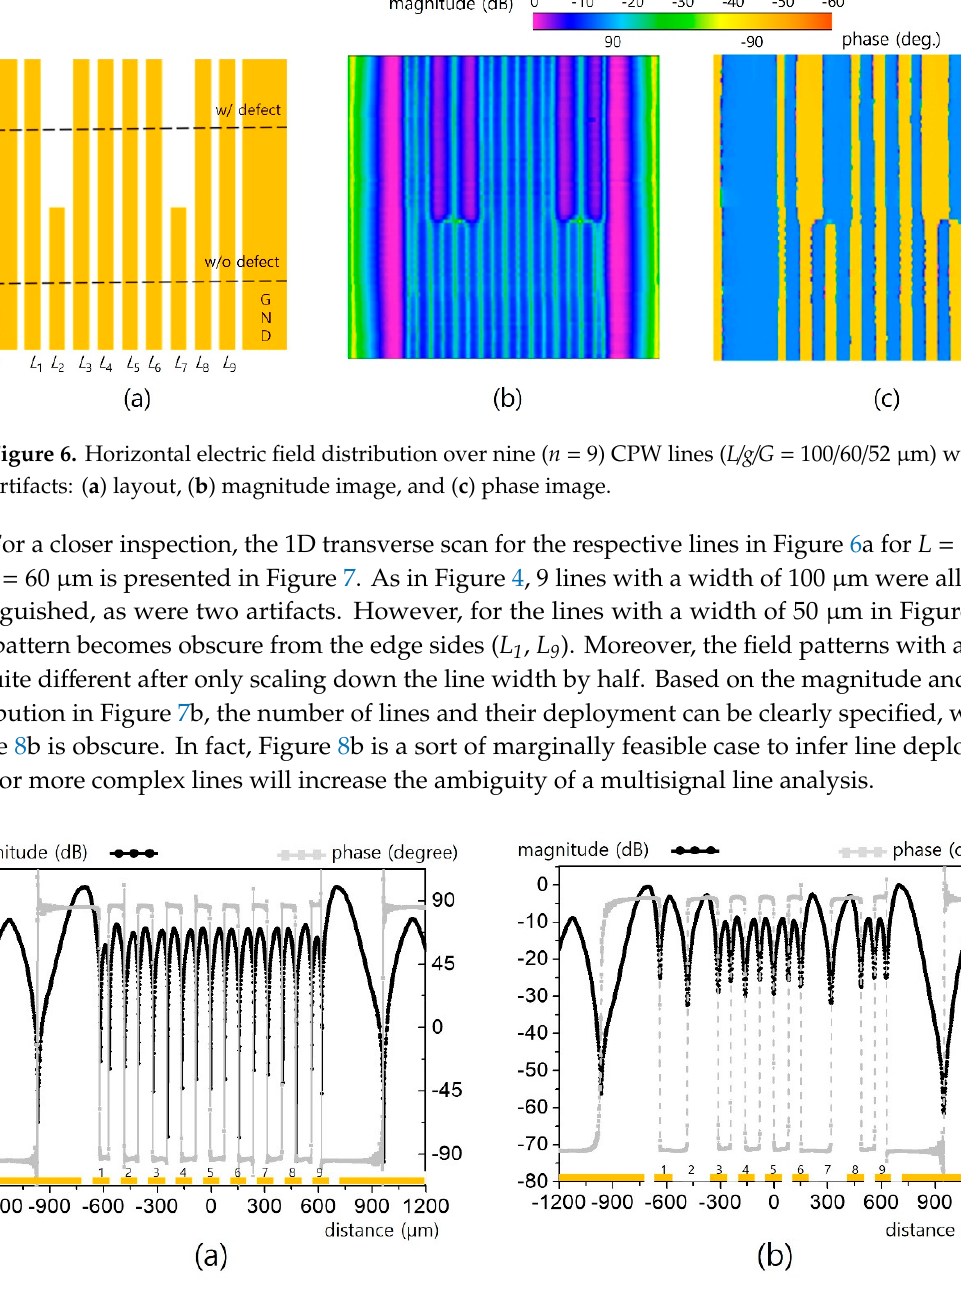
Figure 7. Horizontal electric field distribution over nine ( n = 9, L/g/G = 100/60/52 μ m) CPW lines in Figure 6: ( a ) for lines without defects, and ( b ) for line with defects.